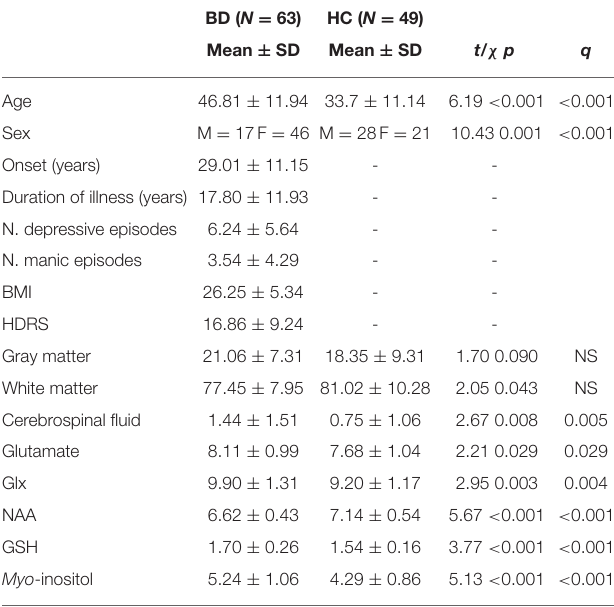
TABLE 1 | Clinical and demographic characteristics of the sample and results of proton magnetic resonance spectroscopy in the anterior cingulate cortex divided according to